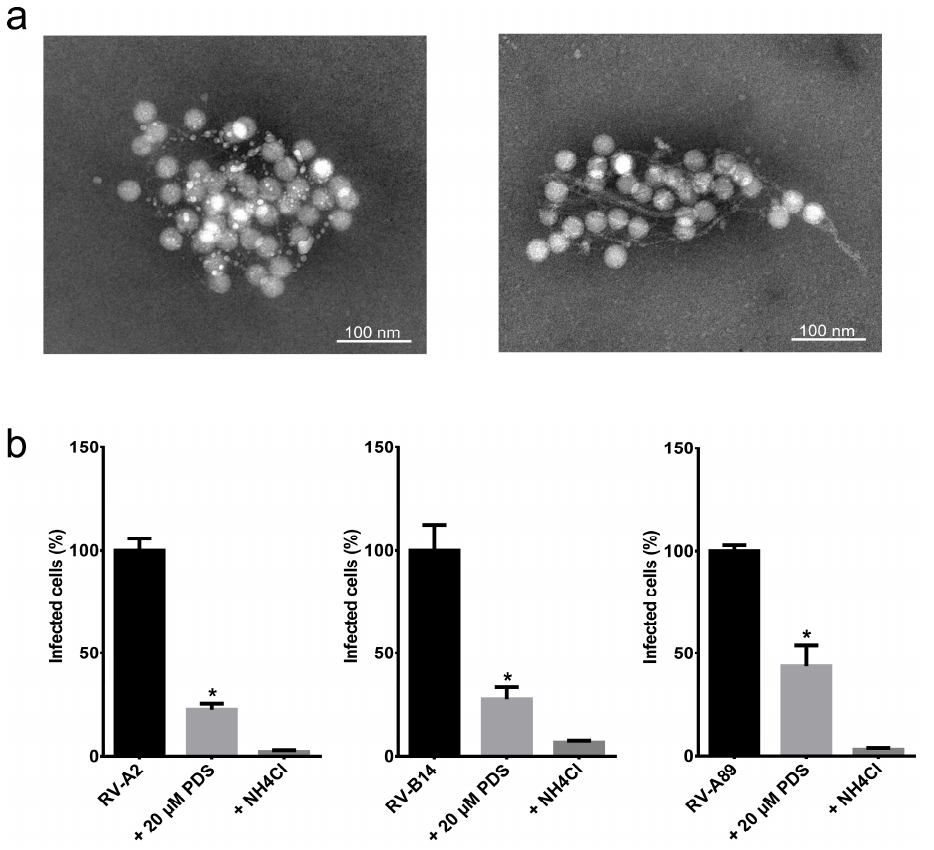
Figure 2. PDS fibrils entrap various RVs. ( a ) RV-A2 (1 µ g / mL) was mixed with PDS at 20 µ M in Tris bu ff er, transferred onto EM grids, stained with 2% phosphotungstic acid (pH 7.4), and viewed by TEM. ( b ) HeLa cells, 80% confluent, were either infected with RV-A2, RV-B14, or RV-A89, respectively (controls), or pre-incubated with 20 µ M PDS in Tris bu ff er for 30 min on ice prior to infection